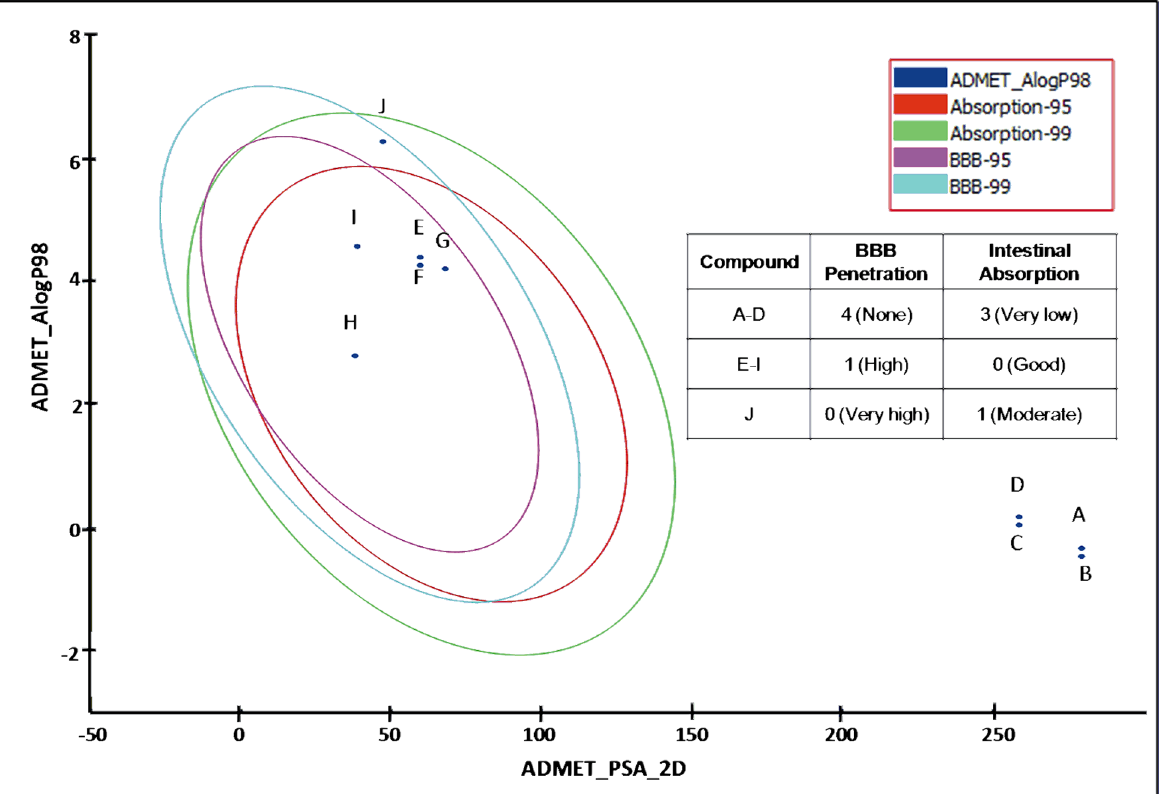
Fig 3. BBB penetration and intestinal absorption properties by ADMET descriptors. (A) bacoside A3, (B) bacopaside II, (C) bacopasaponin C, (D) bacopaside X, (E) jujubogenin, (F) pseudojujubogenin, (G) bacogenin A1, (H) tacrine, (I) donepezil and (J) ebelin lactone. Tacrine and donepezil were used as standard orally active CNS drugs. ADMET prediction level for Human intestinal absorption (HIA)- 0 (good), 1 (moderate), 2 (poor), 3 (very poor); Blood brain barrier (BBB)- 0 (very high penetrant), 1 (high), 2 (medium), 3 (low) and 4 (undefined). The aglycones and its acid hydrolysis derivatives showed better intestinal absorption and BBB penetration compared to the parent